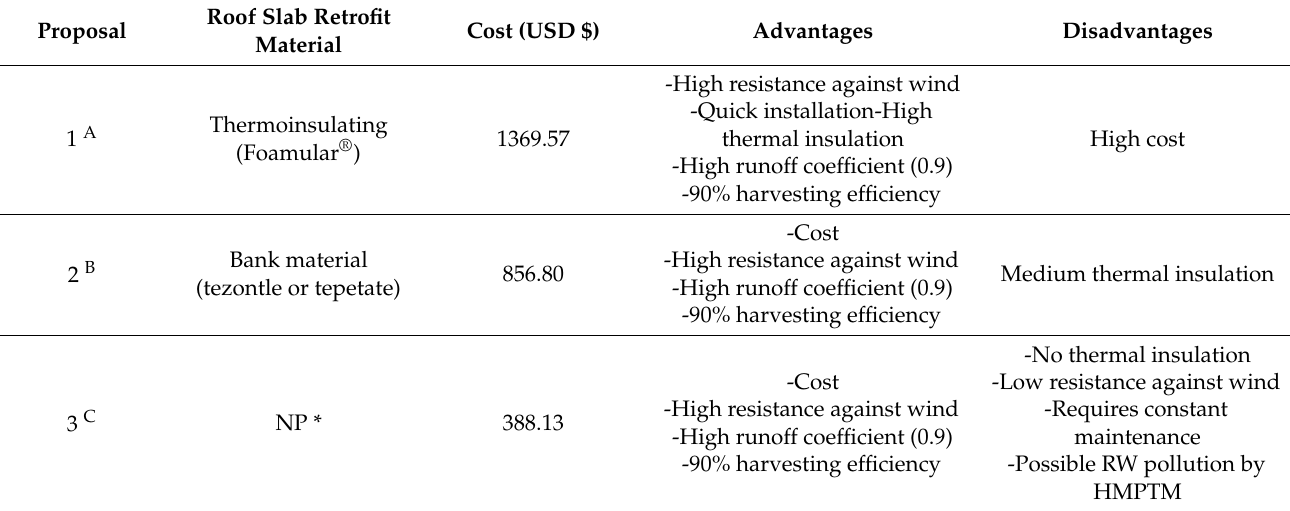
Table 6. Slab retrofit architectural proposal to adopt a rainwater harvesting